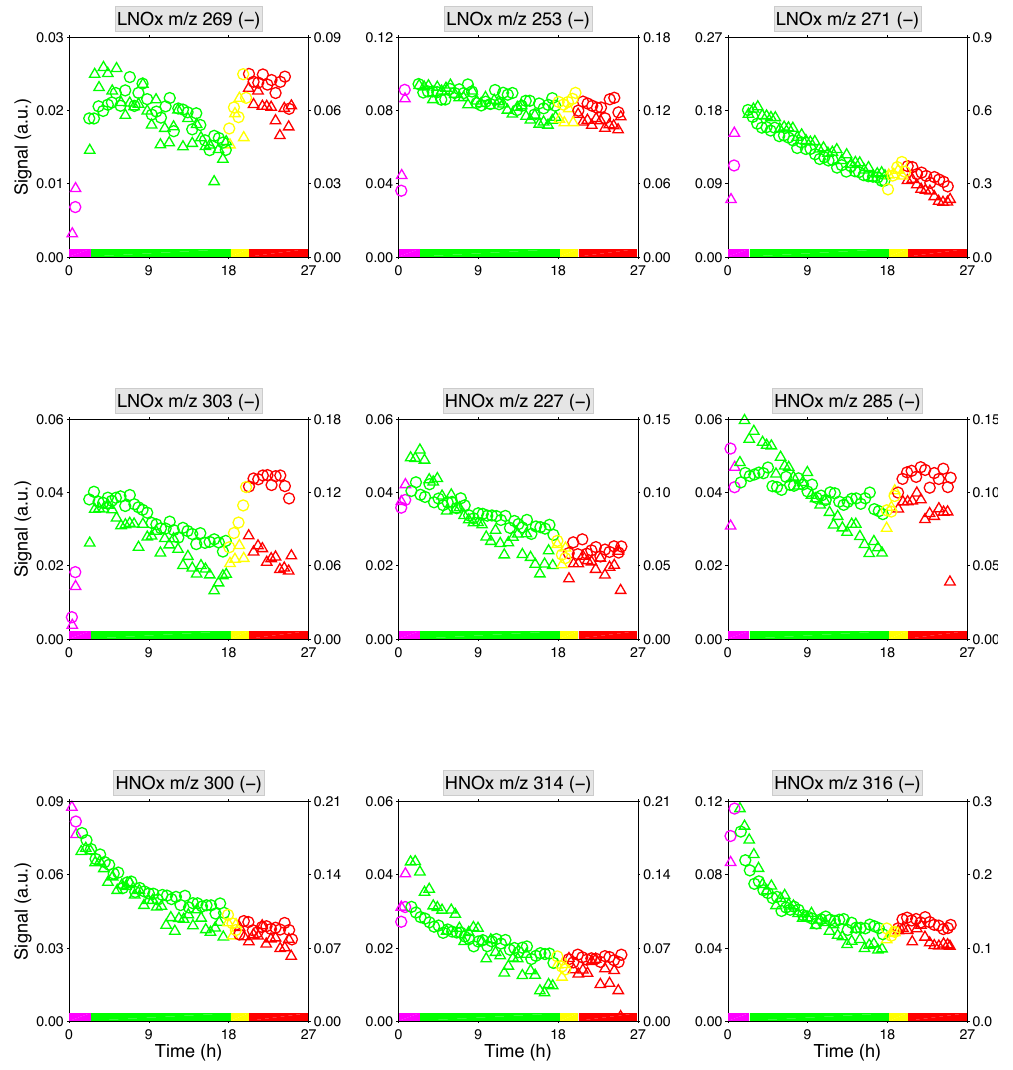
Figure 4. Comparison of vapor–wall interactions for α -pinene + OH products under controlled experimental conditions in used (triangle) vs. unused (circle) Teflon chambers. 30-min averaged data are shown here for clarity. Colored bands denote successive experimental periods: vapor generation (magenta), vapor wall deposition at 298K (green), temperature ramp (yellow), and vapor re-evaporation at 318K